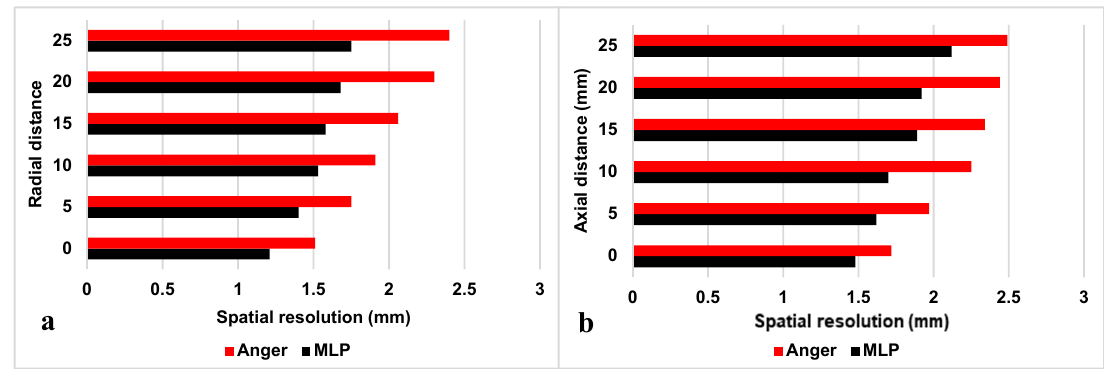
Figure 4. ( a ) Radial and ( b ) axial spatial resolutions of the PET scanner for a point source at five distances from the center of the Z -axis calculated using the National Electrical Manufacturers Association (NEMA) NU-4 protocol.